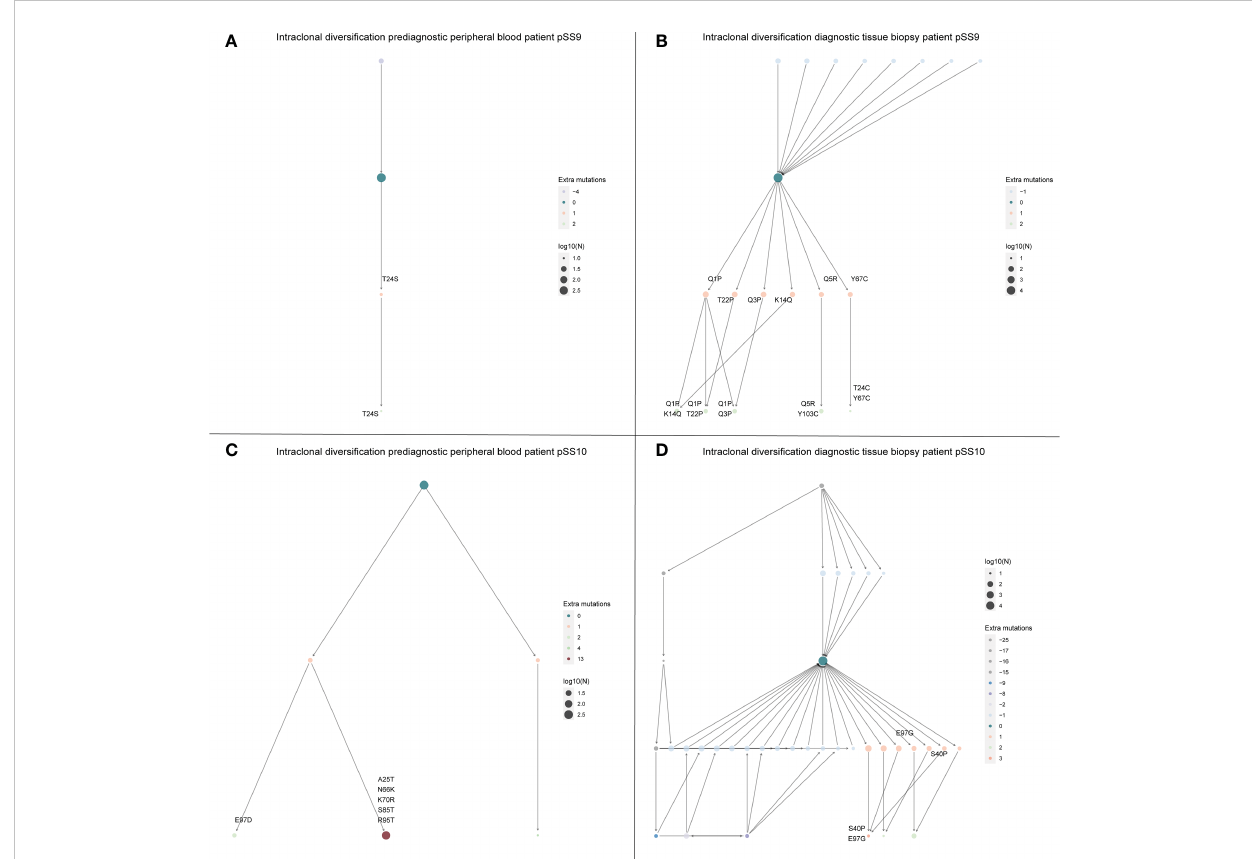
FIGURE 4 Intraclonal diversi fi cation of the eMZL clonotype is strongly reduced in the peripheral blood vs. the diagnostic tissue material. The intraclonal diversi fi cation (ID) of the eMZL clonotype in pSS patients is shown for two patients with prediagnostic PBMC samples available. For these two patients a fresh frozen tissue biopsy was available at eMZL diagnosis. Subclones with reduced mutational load are indicated as precursors, while subclones with additional mutations are indicated as diversi fi cation within the eMZL clonotype. (A) ID pattern in patient pSS9 in the peripheral blood prior to eMZL diagnosis (B) ID pattern in the diagnostic tissue biopsy of patient pSS9. (C) ID pattern in patient pSS10 in the peripheral blood prior to eMZL diagnosis. (D) ID pattern in patient pSS10 in the diagnostic tissue biopsy of patient pSS10. Log10(N) refers to the number of sequencing reads assigned to each subclone and is used to scale the size of each